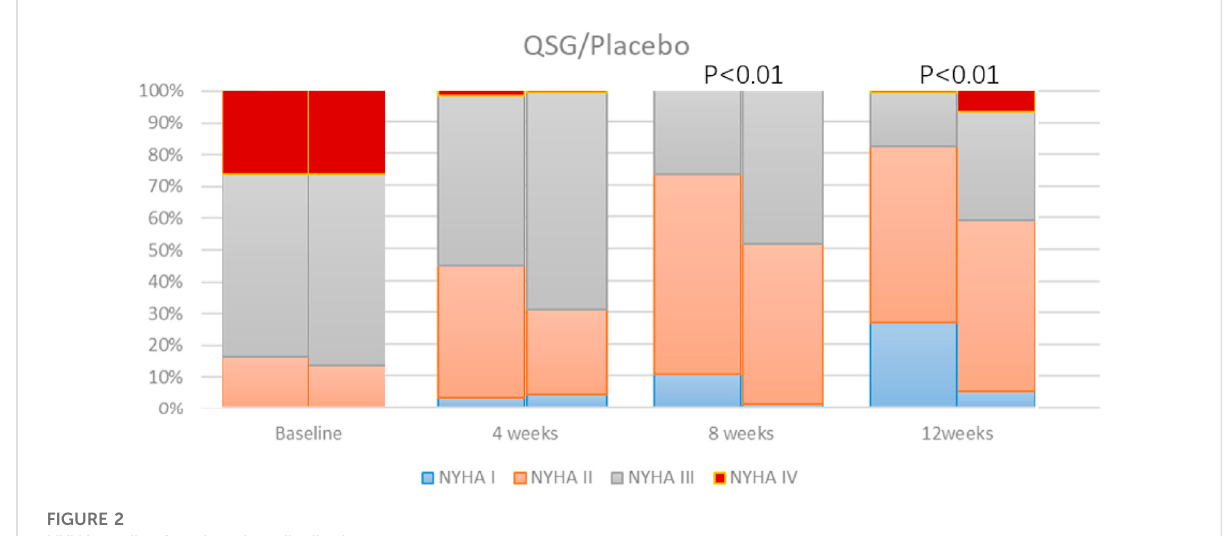
FIGURE 2 NYHA cardiac function class distribution.